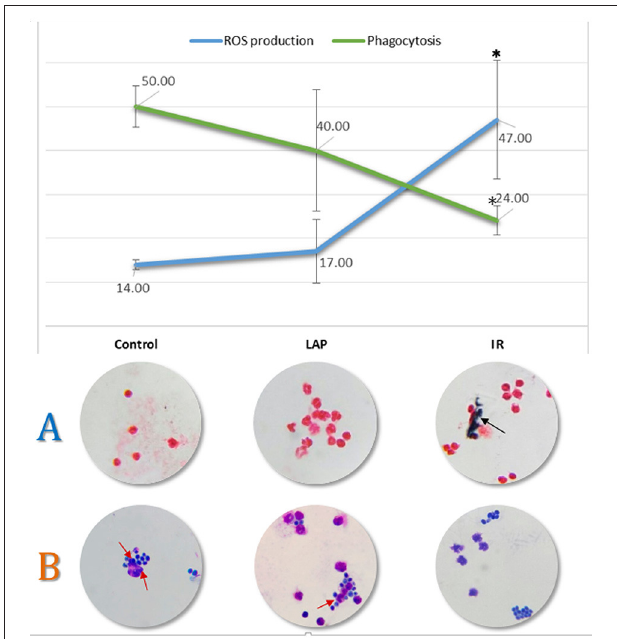
FIGURE 4 | Evaluation of ROS production and phagocytosis. The line graph shows the results of neutrophil function assays obtained by optical microscopy analysis—Phagocytosis in green and ROS production in blue. The asterisk represents significant differences ( p < 0.05) when compared to control or to LAP groups. Cell counts were normalized to one hundred cells. Typical cells are shown below their respective condition in the graph for ROS evaluation (A) where the black arrow points to formazan crystals and phagocytosis (B) of Saccharomyces cerevisiae pointed by red